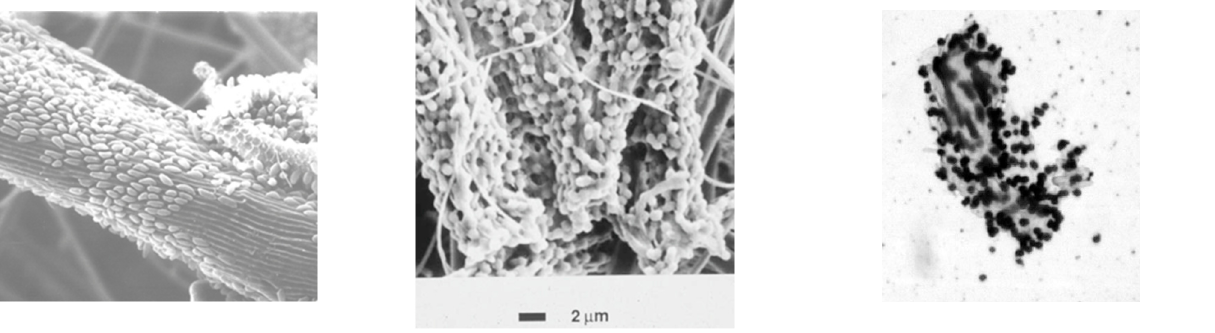
Figure 1. The three predominant species of ruminal cellulolytic bacteria adhering to fibers of pure cellulose. Left panel: Scanning electron micrograph of Fibrobacter succinogenes S85. This species adheres via pilins, fibro-slime proteins and carbohydrate-binding modules (CBMs) bound to its cell wall. Partial removal of cells during sample preparation reveals parallel grooves resulting from oriented degradation of the cellulose fiber along its crystallographic axis. Center panel: Scanning electron micrograph of Ruminococcus flavefaciens FD-1. Right panel: Light micrograph of crystal violet-stained Ruminococcus albus 7. Both species of ruminococci adhere via pilins and CBMs, and stabilize adherence by producing an extracellular glycocalyx composed of carbohydrate and protein.